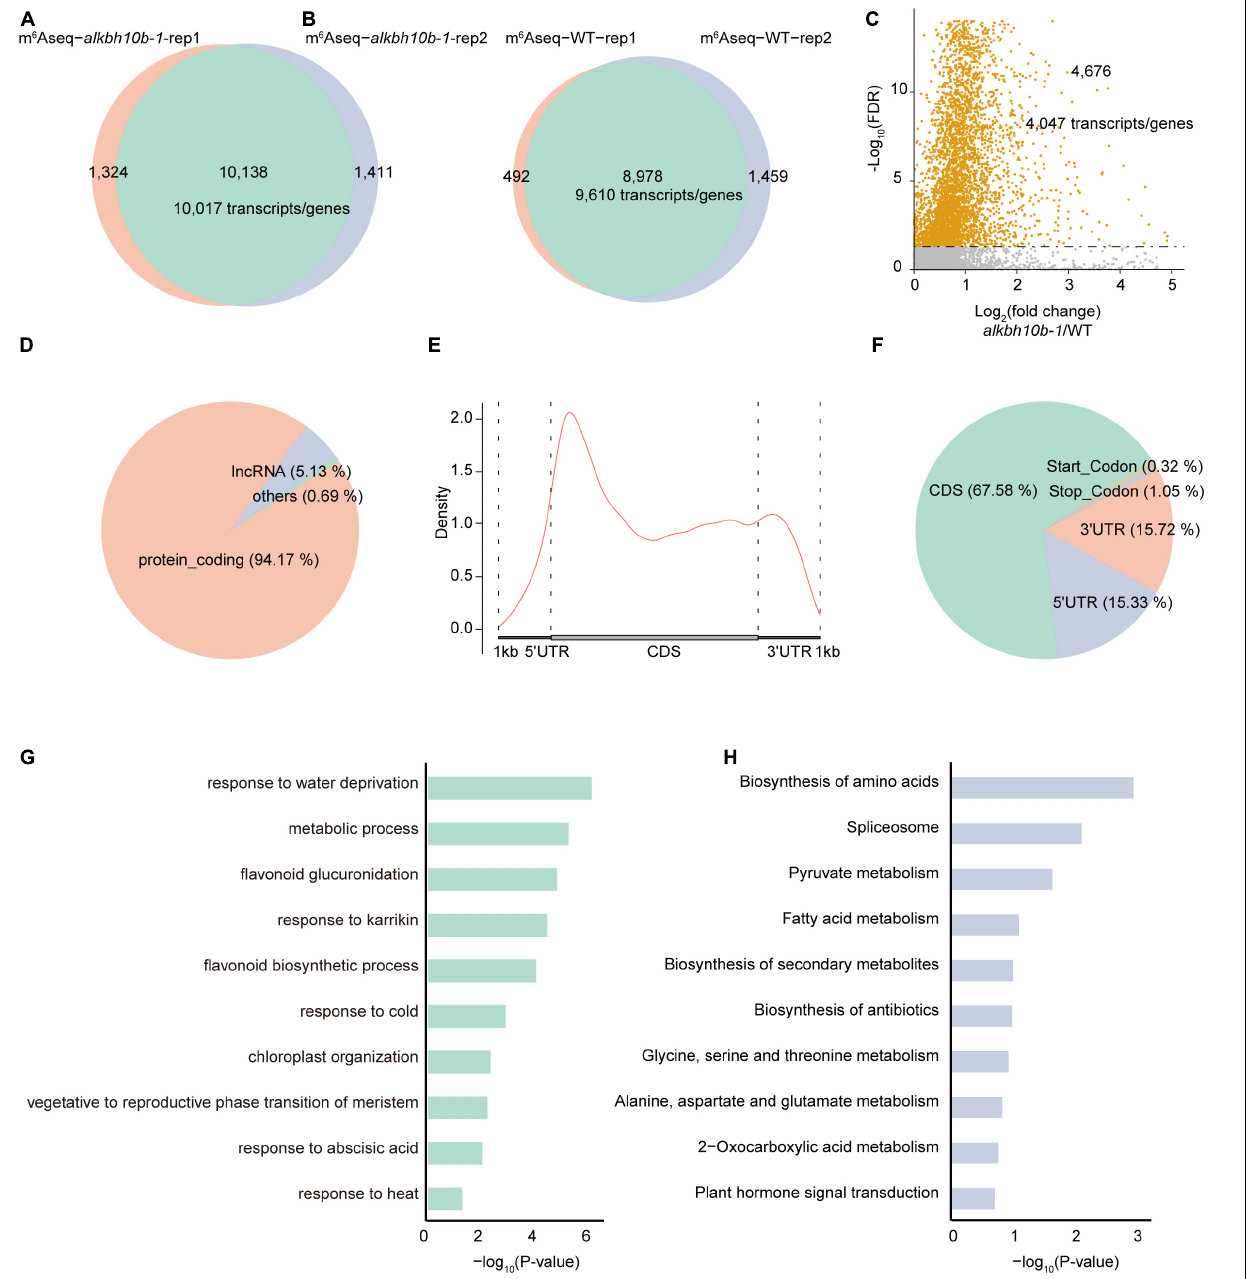
FIGURE 6 | Characterization of m 6 A modification in Col-0 and alkbh10b-1 under ABA treatment. (A) Overlap of two biological replicates of m 6 A enriched peaks in alkbh10b-1 . (B) Overlap of two biological replicates of m 6 A enriched peaks in Col-0. (C) Volcano plot showing the hypermethylated m 6 A peaks identified in alkbh10b-1 compared with Col-0. (D) Pie chart depicting RNA types of hypermethylated m 6 A peaks in alkbh10b-1 . (E) Metagene profile showing the density of hypermethylated m 6 A peaks across the transcript. (F) Pie chart depicting the fraction of the hypermethylated m 6 A peaks in the five non-overlapping transcript segments [5 (cid:48) UTR, start codon, coding sequence (CDS), stop codon and 3 (cid:48) UTR]. (G) Biological process enrichment analysis of genes with hypermethylated m 6 A peaks. (H) Pathway analysis of genes with hypermethylated m 6 A